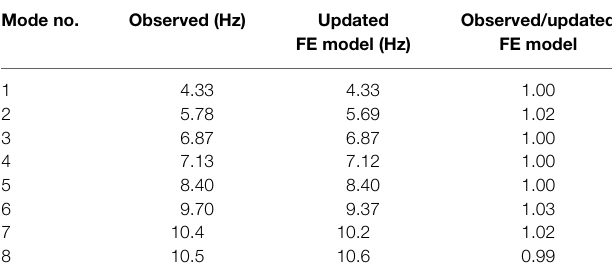
TABLE 5 | Results of stiffness updating for the building before the earthquake: comparison of observed natural frequencies with the analytical ones of the updated finite element